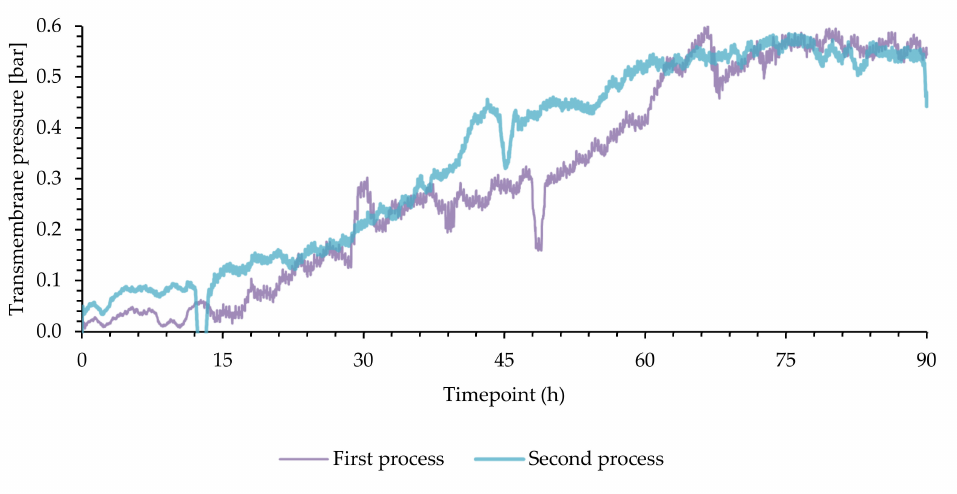
Figure 4. Transmembrane pressure of the two cell recycle processes with Bacillus megaterium uyuni S29. The membrane pressure curves are shown as 60 min rolling